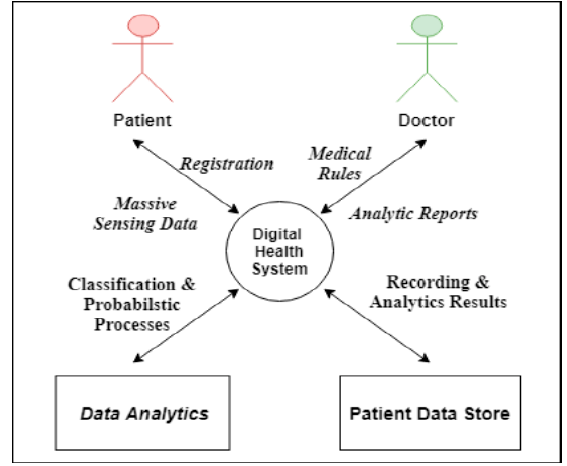
Figure 3. Digital healthcare system context